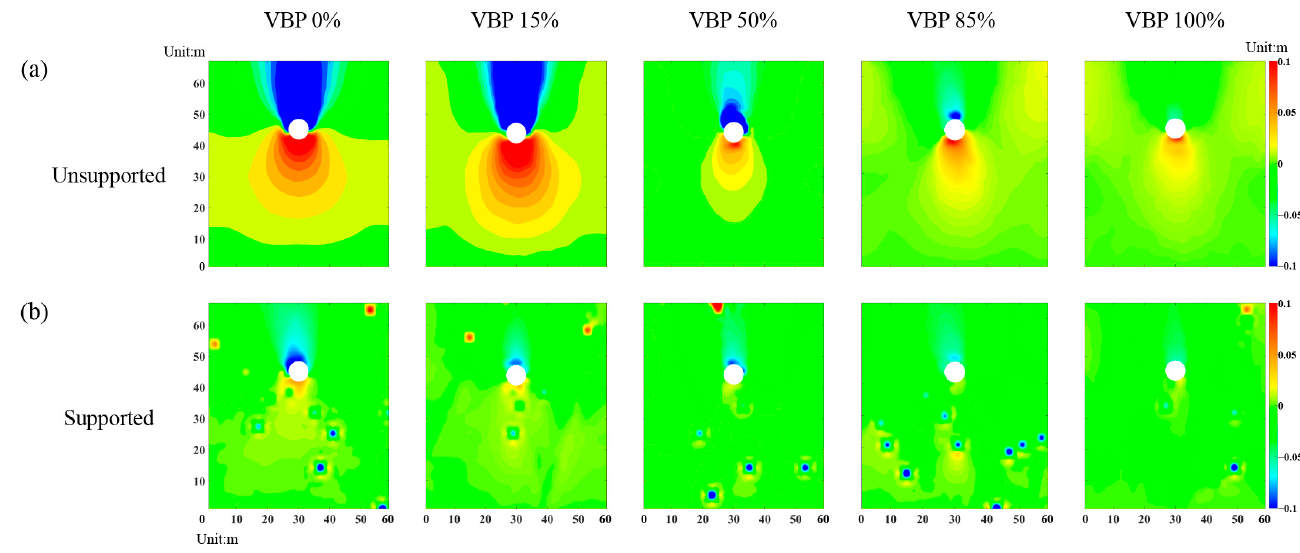
Figure 17. The distribution of vertical displacement in the talus-like rock mass with ( a ) unsupported tunnel excavation and ( b ) supported tunnel excavation.